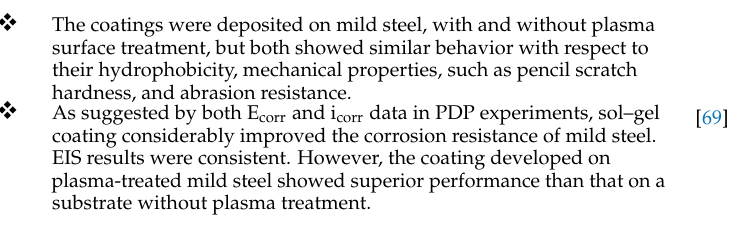
Table 1. Different approaches for improving silane coatings and the main findings, as reported in the